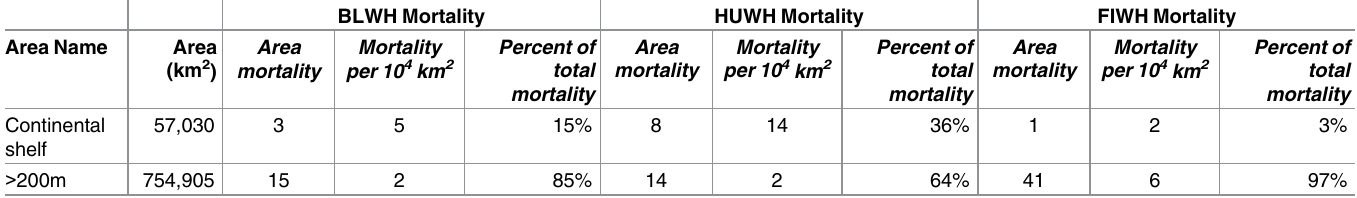
Table 9. Mortality on and off the continental shelf (defined by the 200-meterisobath). Mortality per 100,000km 2 and percent of total study area mortal- ity are also reportedfor each